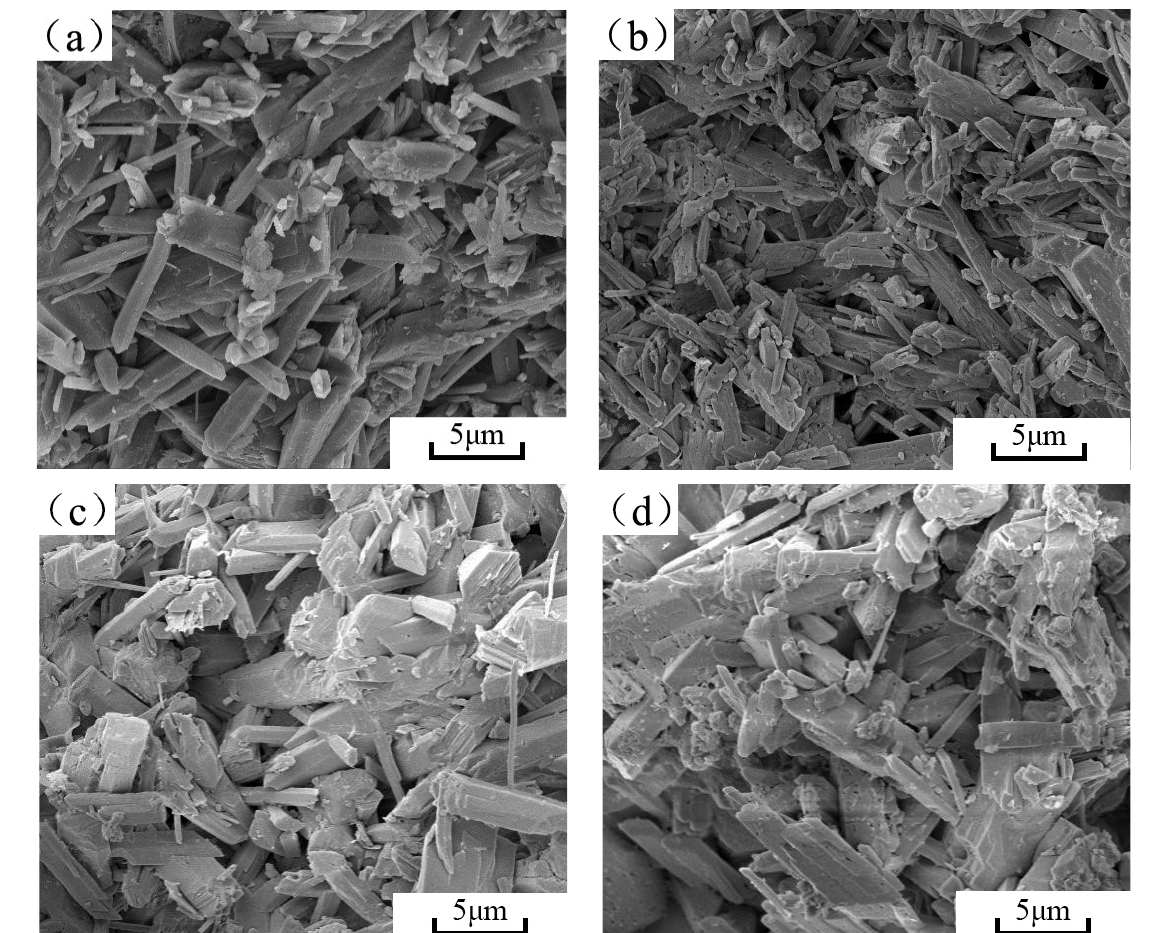
Figure 7. SEM image of plaster sample cross-sections. ( a ) Reference group; ( b ) phosphogypsum +0.3 wt.% hydrophobic agent; ( c ) phosphogypsum +0.3 wt.% hydrophobic agent +0.4 wt.% cement; ( d ) phosphogypsum +0.3 wt.% hydrophobic agent +0.6 wt.% cement.